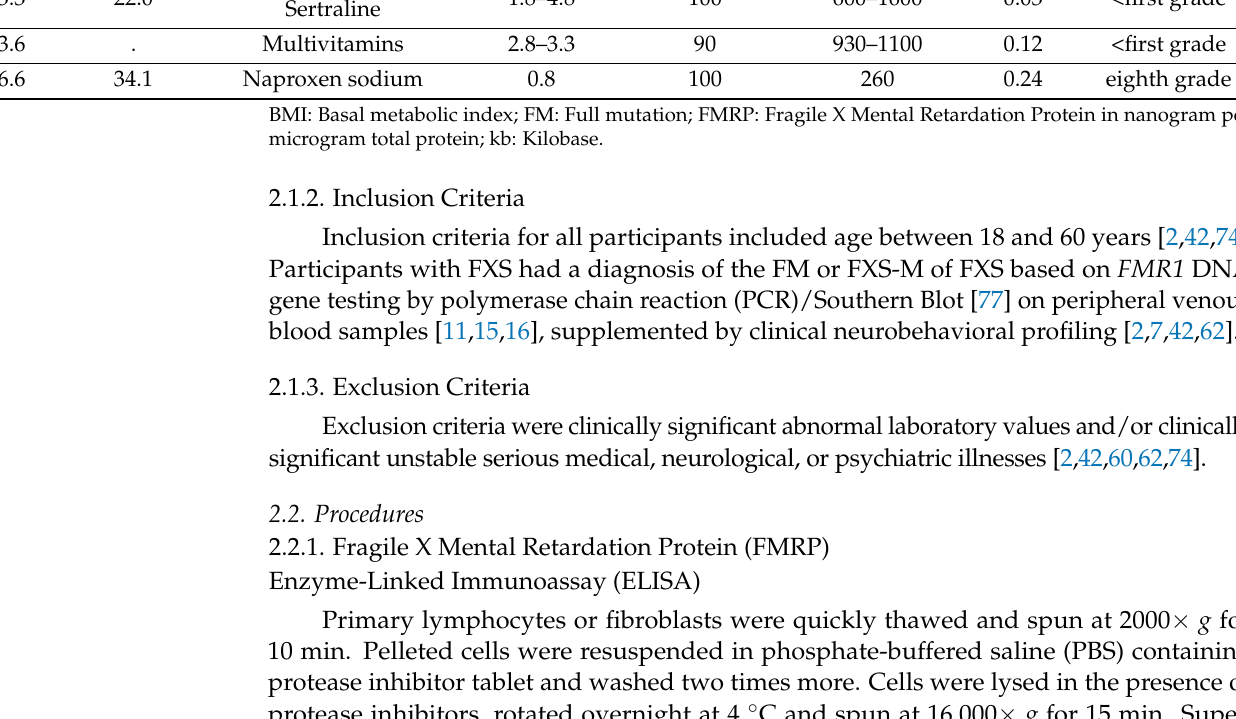
BMI: Basal metabolic index; FM: Full mutation; FMRP: Fragile X Mental Retardation Protein in nanogram per microgram total protein; kb: